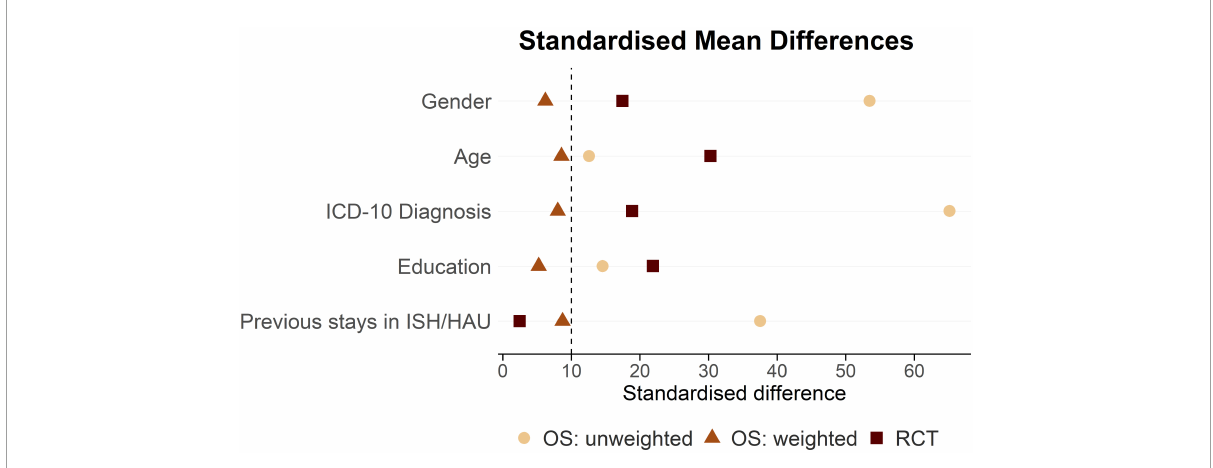
FIGURE3 Standardised differences of unweighted and IPTW-weighted covariates included in the PS-model. RCT, randomised controlled study; OS, observational study; ISH, Independent Supported Housing; HAU, housing as usual; IPTW, inverse probability of treatment weighting; PS, propensity